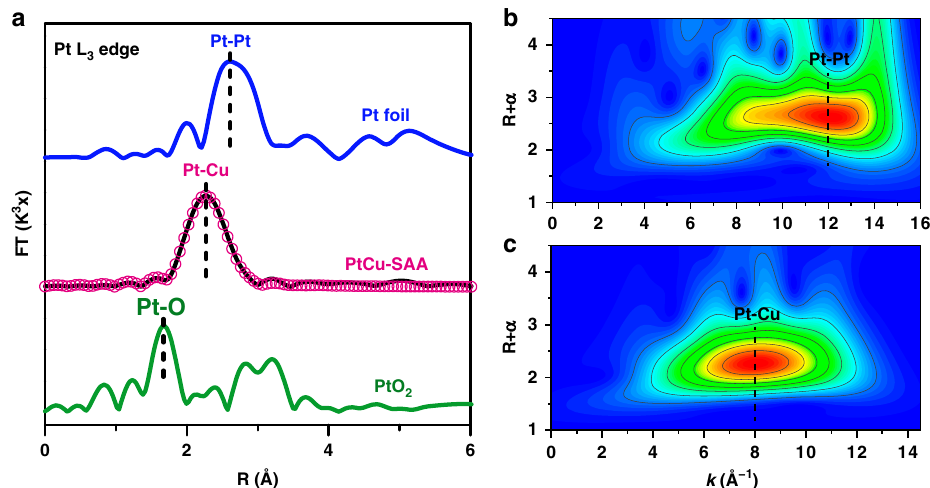
Fig. 4 Characterization and identi fi cation of PtCu single atom alloy. a In situ Pt L 3 – edge EXAFS Fourier – transform spectra of Pt foil, PtCu − SAA (the empty magenta circle: fi tting curve; the black solid line: experimental data) and PtO 2 sample, the in situ EXAFS wavelet transforms spectra of b Pt foil and c PtCu – SAA, respectively.